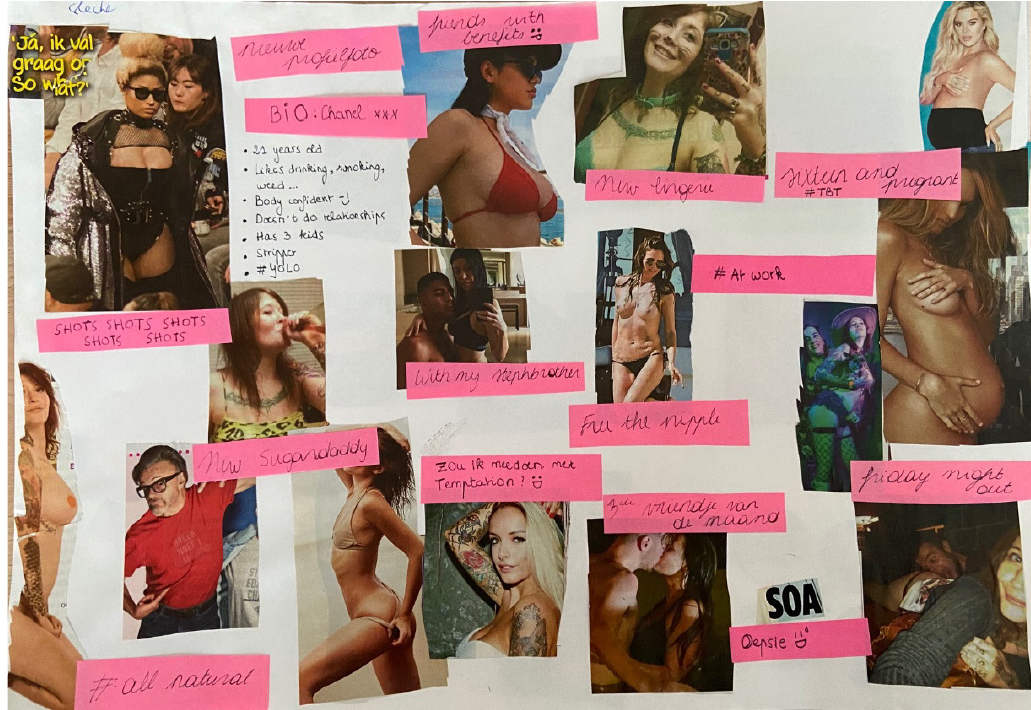
Figure 2. Fictional Instagram of Chanel symbolizing “bad”